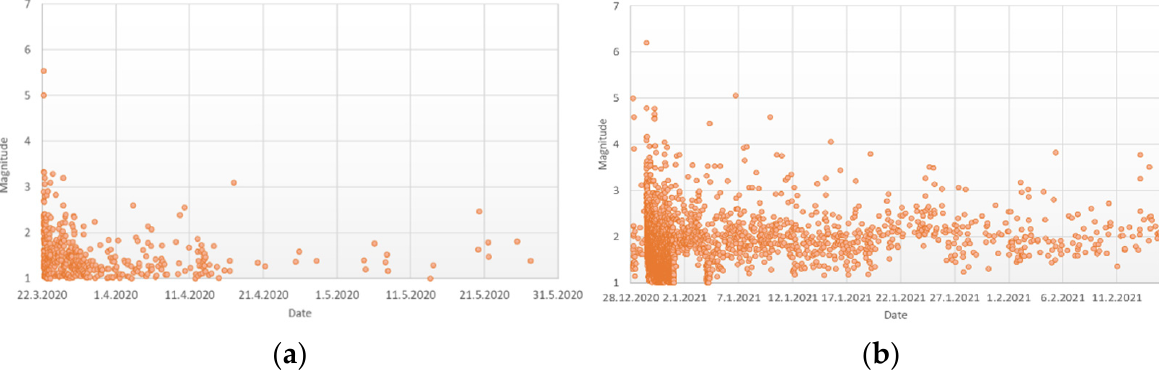
Figure 1. ( a ) Magnitudes from the 22 nd March earthquake in Zagreb; ( b ) Magnitudes from the 30 December 2020 earthquake in Petrinja.